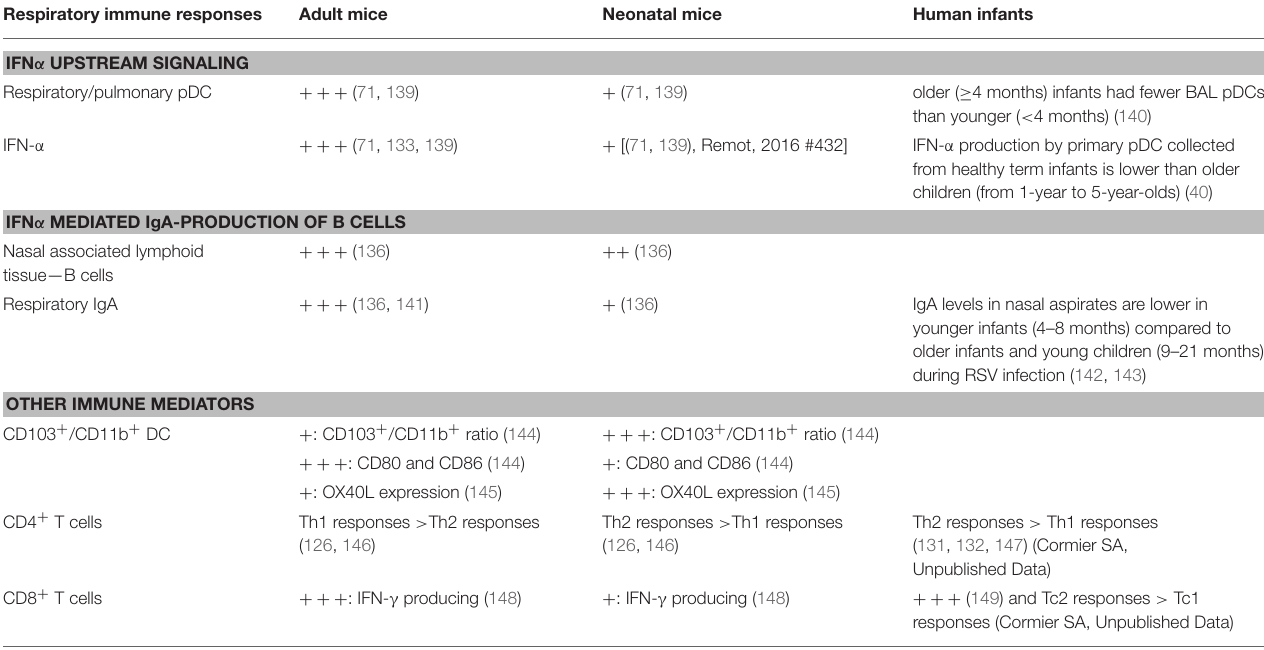
TABLE 1 | Differences in immunological responses toward RSV in the respiratory